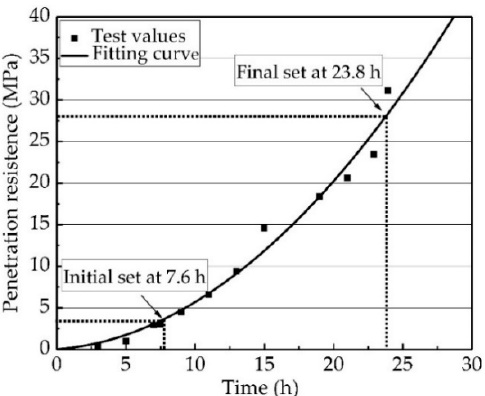
Figure 2. Results from the penetration test showing times of the initial set and the final set.